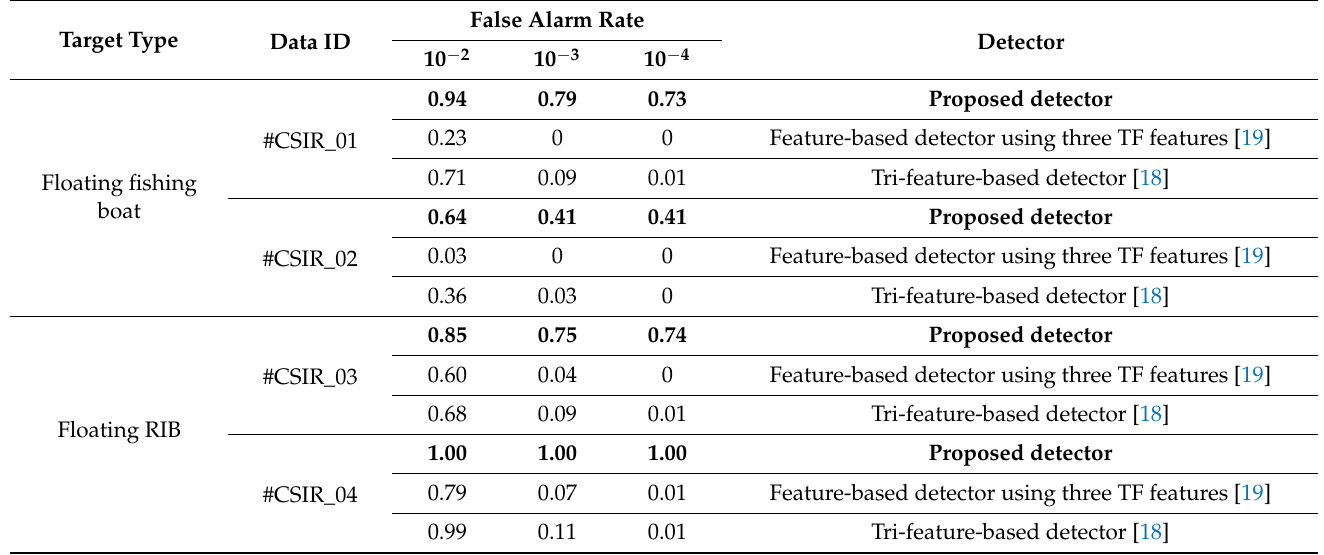
Table 4. The detection probability of different detection methods with different false alarm probabili- ties. The radar observation time is 0.512 s. Bold highlights the comparison results.